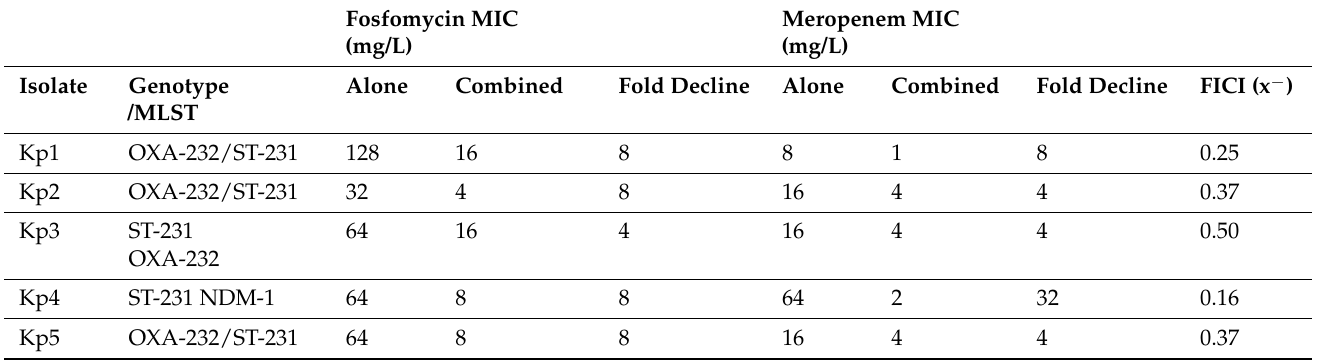
Table 3. Synergy outcomes of fosfomycin-meropenem combination using the Checkerboard assay